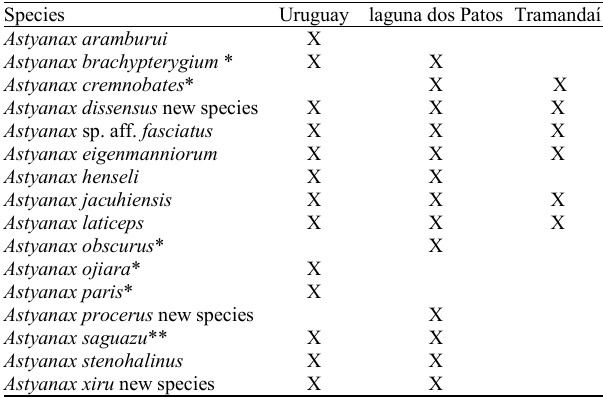
Table 2. Astyanax species recognized from rio Uruguay basin, and laguna dos Patos and rio Tramandaí systems by